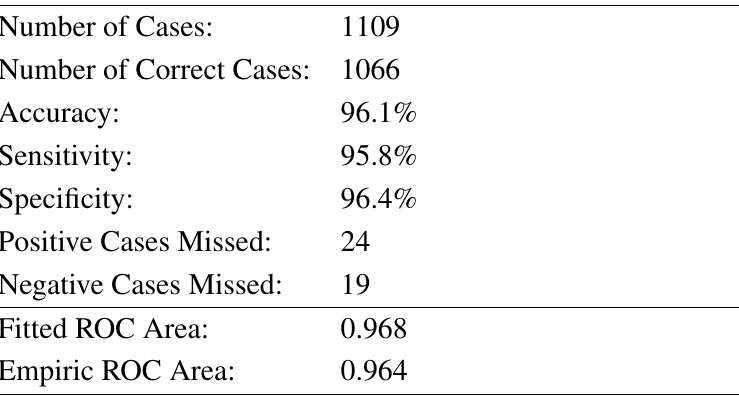
Table 5. Algorithm performance statistics for the color video